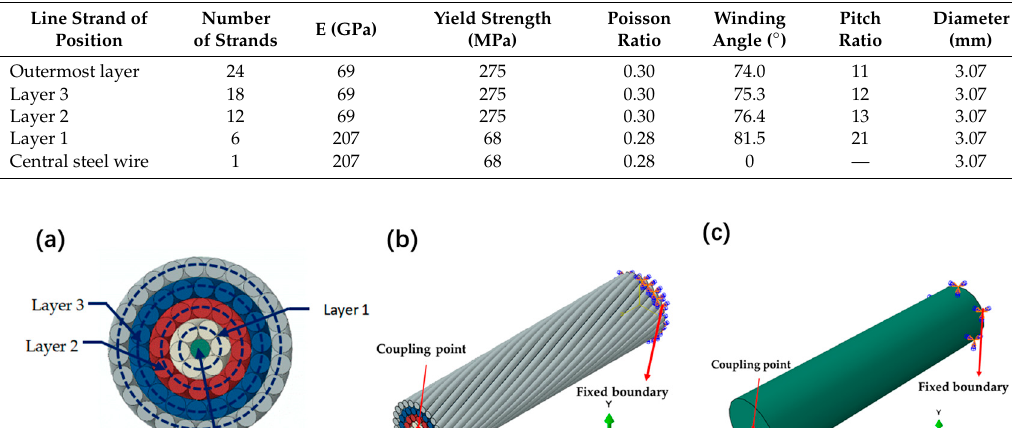
Table 1. Mechanical properties of materials and modeling parameters of the local finite element model. Line Strand of